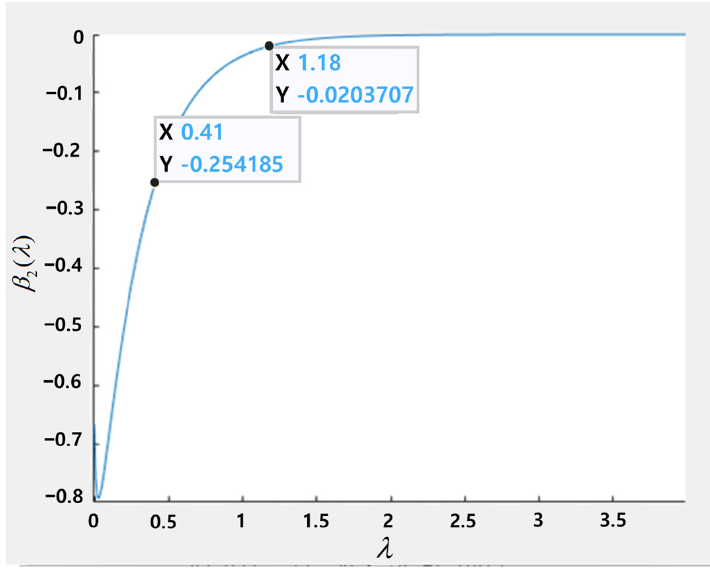
Figure 11. β  (λ) according to Equation (32). Figure 11. β ( λ ) according to Equation (32). 2